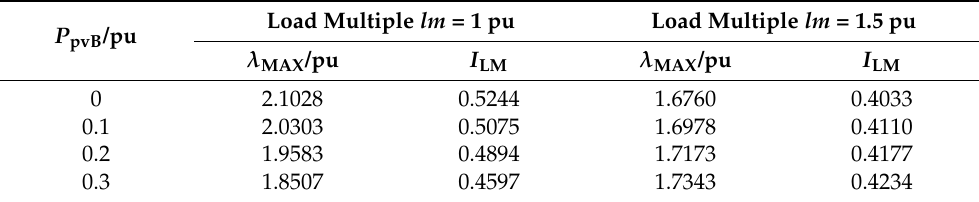
Table 7. Values of system load-margin index (Plan C, active output of PV station C P pvC = 1 pu). P pvB